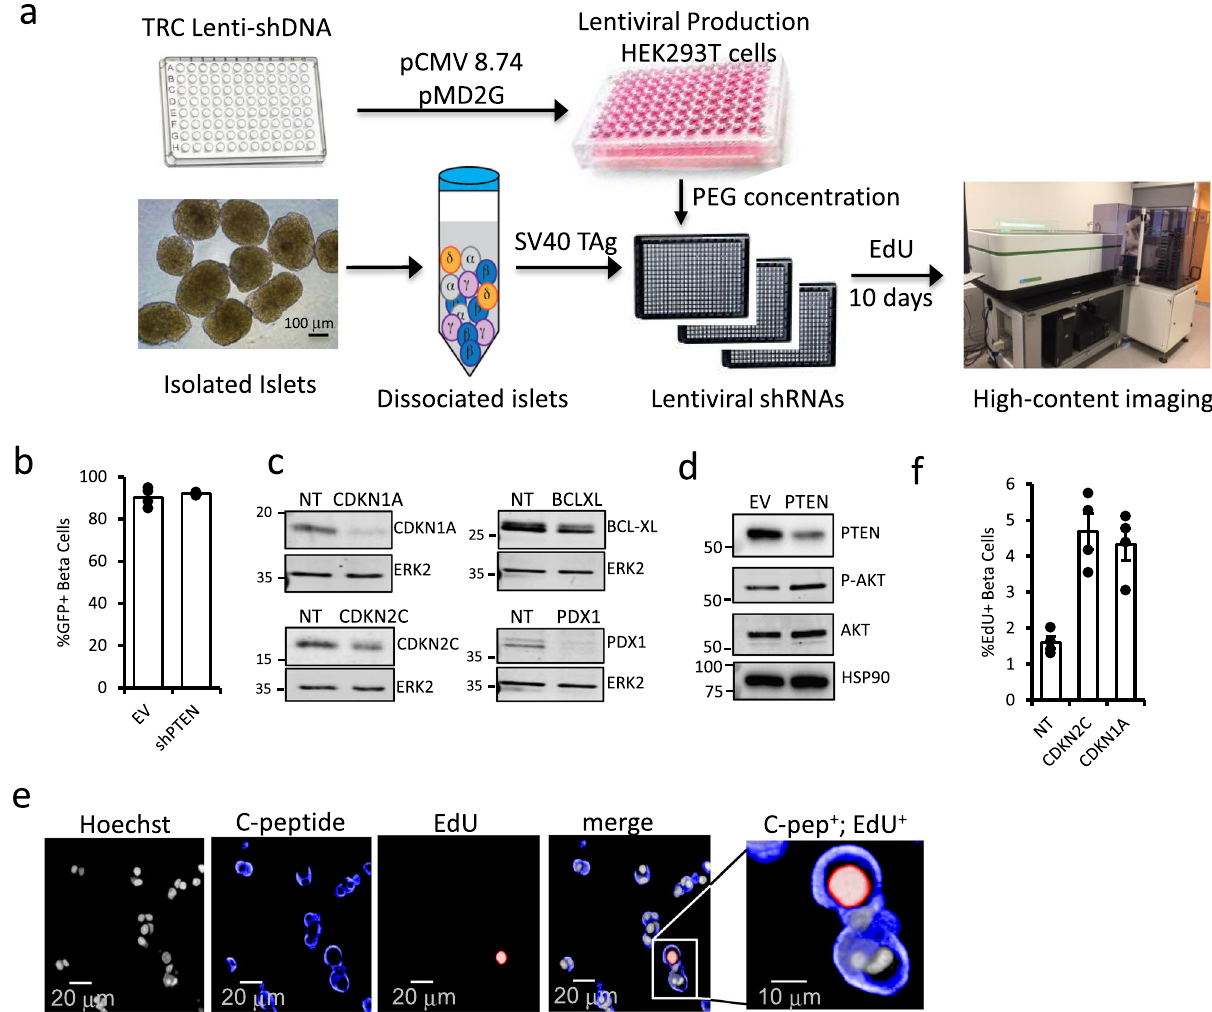
Fig. 1 Automated HTS assay to screen in primary human cells. a Schematic showing the work fl ow of HTS screen, from shDNA plasmid packaging into lentivirus, arraying into 384-well plates and seeding with dissociated human islet cells, prior to 10d culture to permit gene silencing and EdU incorporation. b Bar plot showing % GFP positive, C-peptide positive cells after infection with HTS virus encoding shRNA targeting PTEN or empty vector control. c Representative Western blots showing knockdown ef fi ciency of positive controls following infection with lentiviral-shRNAs against CDKN2C/p18, CDKN1A/p21, BCL-XL, and PDX1. d Effect of silencing PTEN on downstream effector phospho-AKT, with total AKT and HSP90 control is shown. e Representative images of dissociated human islets from positive control well coinfected with TAg and silenced for CDKN1A then stained for nuclei (Draq5, gray), C-peptide (blue), EdU (red), and merged. Scale bar = 20 µ m. Zoom merged image is shown (Scale bar = 10 µ m). f Barplot con fi rming the effectiveness of lentivirus prepared with HTS protocol on silencing CDKN2C and CDKN1A and stimulating human β cell proliferation. p -values: CDKN2C = 0.0011 and CDKN1A = 0.0012. Error bars are de fi ned as the standard error of the mean for n = 4 technical replicates for all statistics. MWs for Western blot markers are in